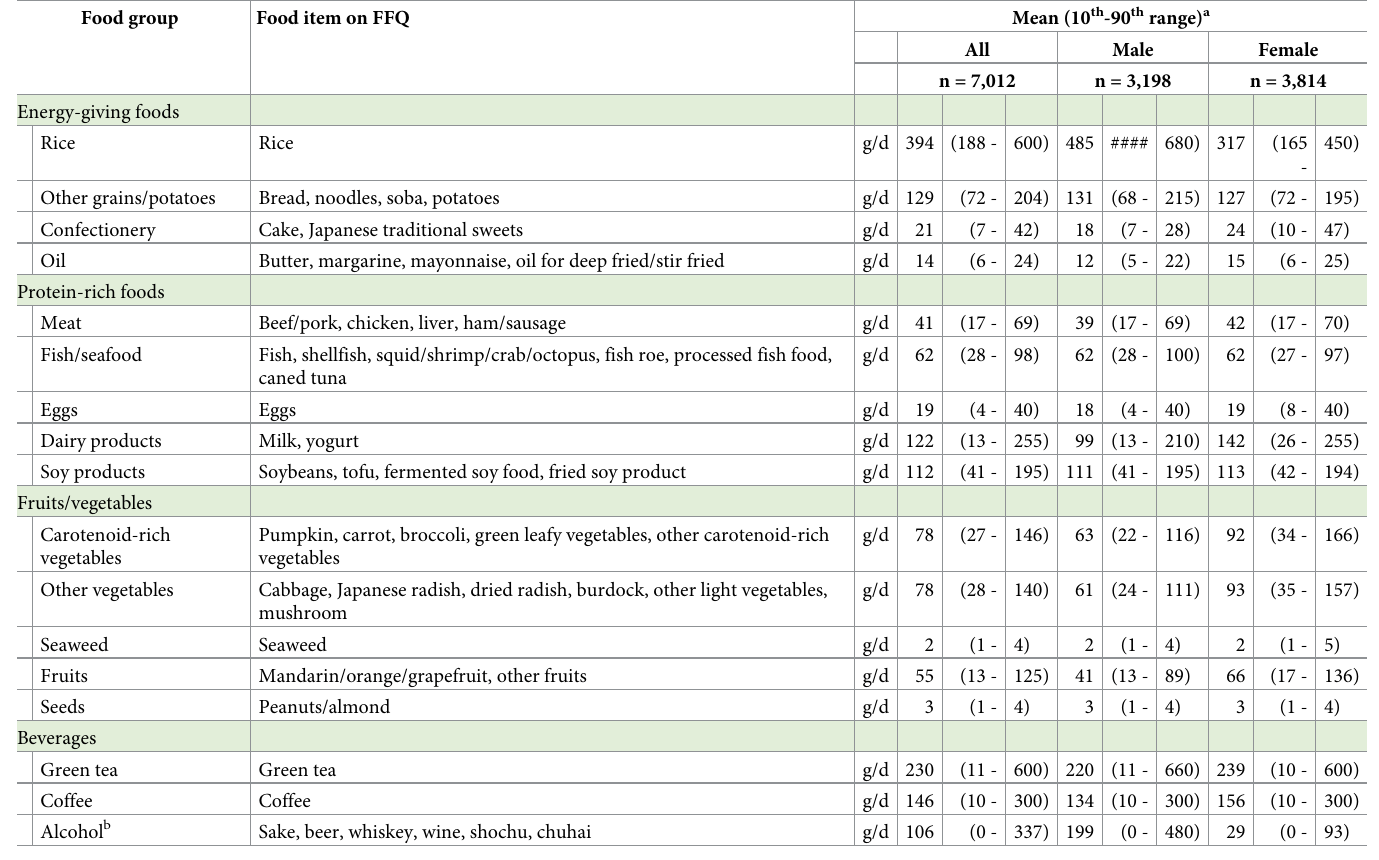
Table 2. Food classification and population intake